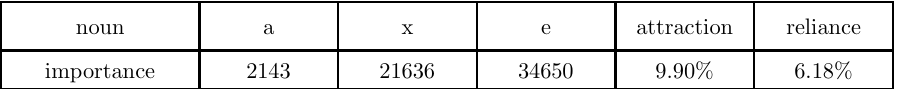
Cooccurrence table for a quantitative